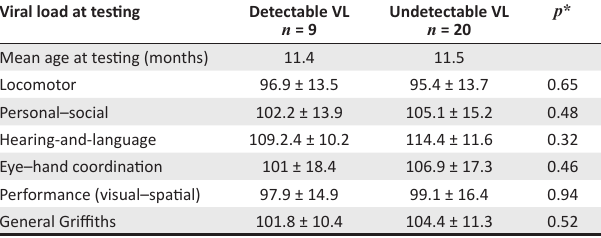
TABLE 4: Comparison of Griffiths Mental Development Scale quotients in those with and without virological suppression at testing. Viral load at